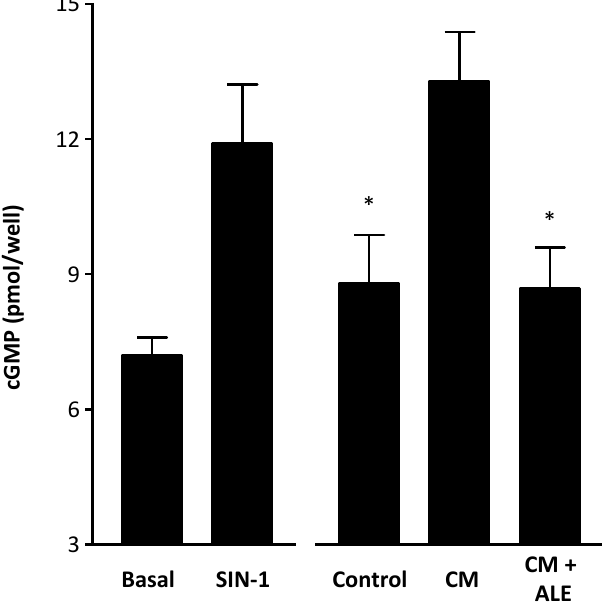
Figure 3. Artichoke leaf extracts prevent CM-induced cGMP production. Human coronary artery smooth muscle cells (HCASMC) were treated with the cytokine mixture (CM) or CM in combination with the artichoke leaf extract (ALE, 10 µg/mL) for 24 h. Then, conditioned media from HCASMC was transferred to RFL-6 reporter cells. The cGMP content in the RFL-6 cells was measured by radioimmunoassay. RFL-6 cells without conditioned media from HCASMC (basal) and RFL-6 cells treated for 3 min with the NO donor linsidomine (SIN-1, 1 µM) served as negative and positive controls, respectively. * p < 0.05, compared with